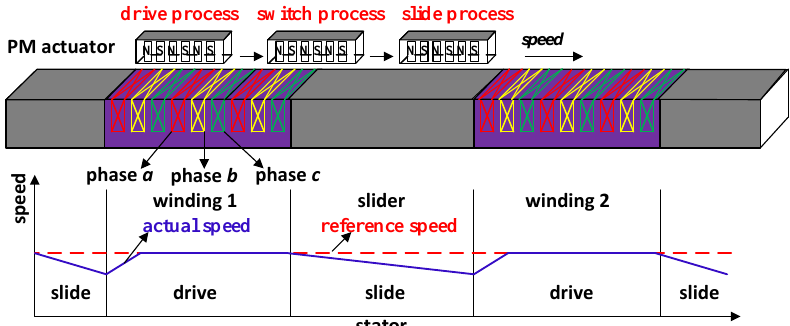
Figure 1. Structure and operational principle of segmented permanent magnet linear synchronous motor (PMLSM).